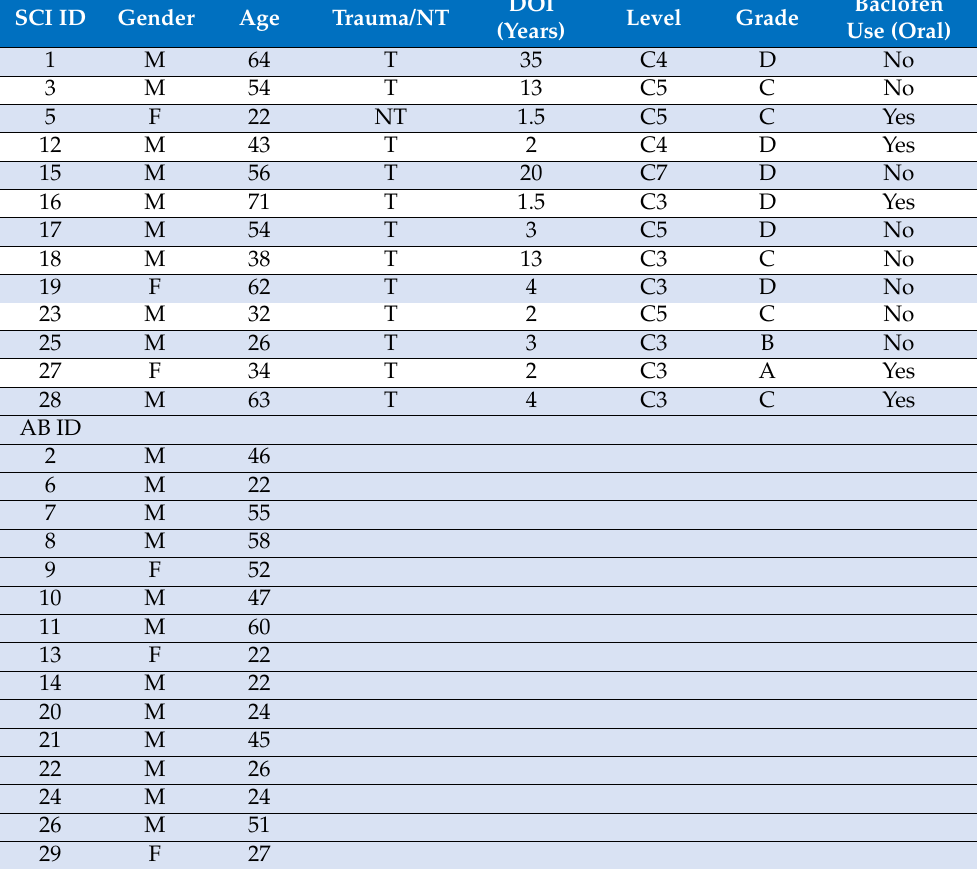
Table 2. Participant demographics. NT—non-traumatic; DOI—duration of injury (years); Level— neurological level of injury; Grade—SCI severity according to International Standards for the Neuro- logical Classification of